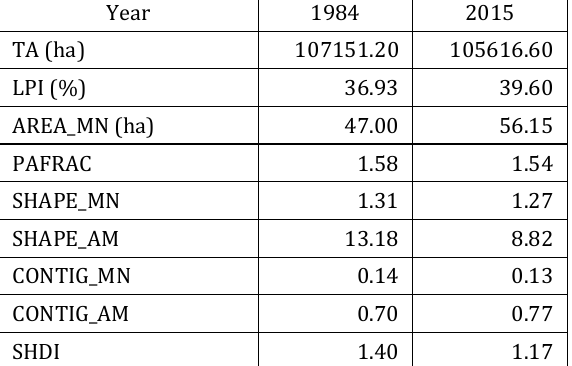
Table 4. Landscape level metrics for 1984 and